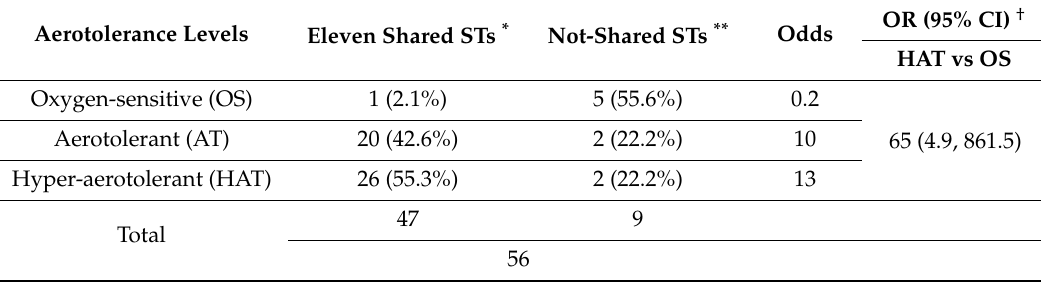
* Eleven STs (MLST sequence types ST827, ST828, ST829, ST830, ST832, ST855, ST860, ST902, ST1055, ST1586, and ST1593) shared between duck sources and the human source (NCBI). ** MLST STs that were not shared